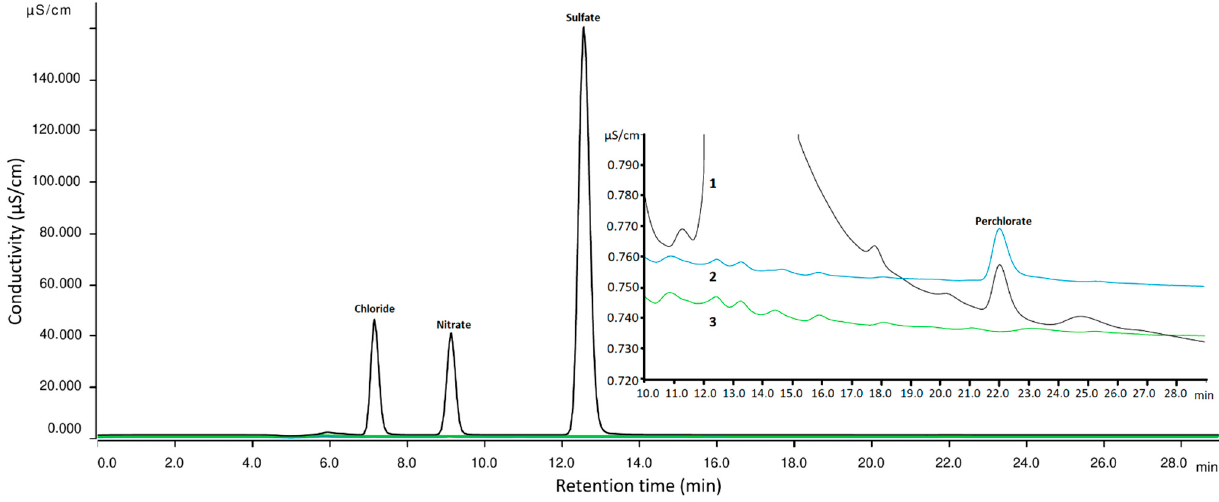
Figure 2. An overlay chromatogram of: (1) river water sample (sample No 8, other matrix ions are present), (2) standard solution (5 µg/L), and (3) blank (deionized water (DI) water).